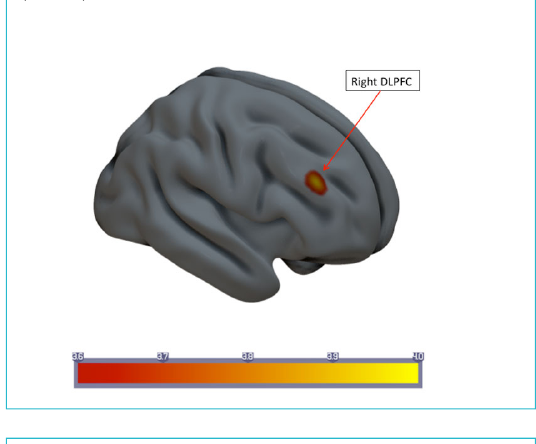
Figure 2: Statistical parametric map of longitudinal changes in mean cerebral blood flow (CBF) in the responder group. Upregula- tion of cortical CBF in the right dorsolateral prefrontal cortex (DLPFC).